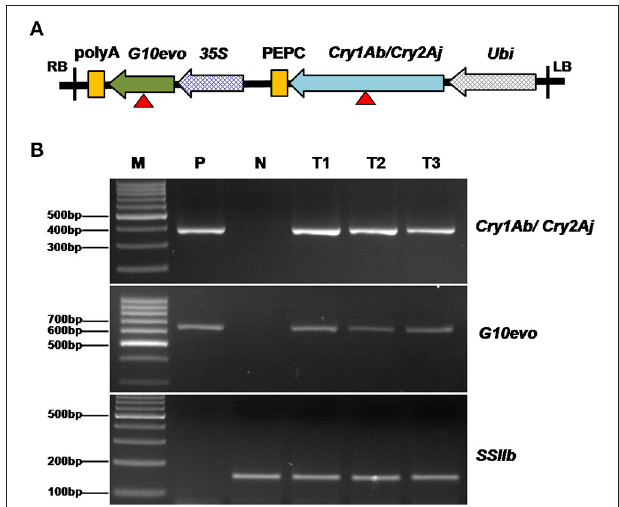
FIGURE 2 | Detection of genetically modified maize SK12-5. (A) Organization of transgenic elements used in SK12-5; the red triangle indicates the location of the primes for the detection of G10evo and Cry1Ab/Cry2Aj . (B) Notably, 3% agarose gel electrophoresis of polymerase chain reaction (PCR) products amplified with the Cry1Ab/Cry2Aj , G10evo event-specific primers and the maize SSIIb gene prime. M, the 1,000-bp DNA ladder; P, transgenic plasmid as the positive control; N, non-transgenic maize line Zheng58 as the negative control; and T1–T3, the three samples of